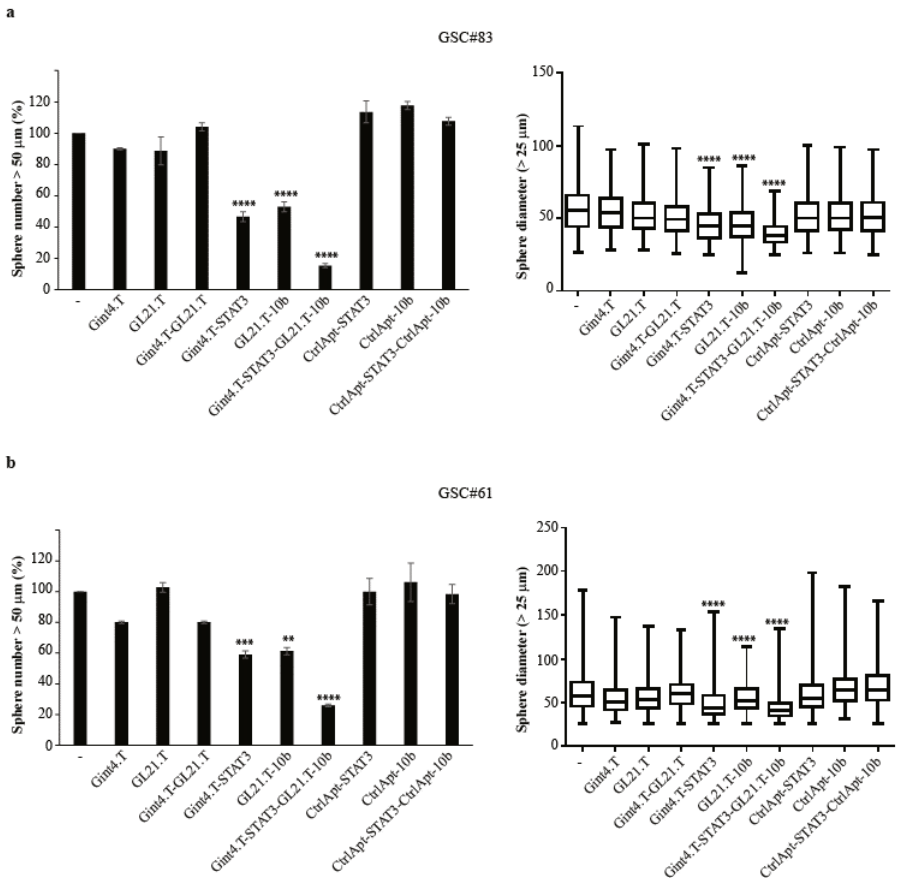
Figure 6. Gint4.T-STAT3 and GL21.T-10b combined effect on primary GSC tumour sphere formation. ( a , b ) Sphere formation of indicated primary GSC-derived tumour spheres (PDGFR β + ) left untreated ( − ) or treated with Gint4.T; Gint4.T-STAT3 or CtrlApt-STAT3; GL21.T-10b; or control aptamers—alone or in combination, as indicated. Left panels: Spheres with a diameter >50 μ m were counted and expressed as the percentage relative to the untreated samples ( − ), set to 100%. Vertical bars depict the mean ± SD ( n = 2). Right panels: Boxplot representation of the diameter measures (spheres with a diameter > 25 μ m). Statistics of the conjugate treatments versus the untreated samples were obtained using one-way ANOVA: **, p < 0.01; ***, p < 0.001; ****, p < 0.0001. 3. Discussion In the present study, we addressed the inhibition of GBM stem-like cells by an aptamer–siRNA molecule, combining the targeting of PDGFR β and STAT3 gene silencing. We used a previously described nuclease resistant conjugate (Gint4.T-STAT3) [25] containing an aptamer (Gint4.T) that binds and inhibits the receptor tyrosine kinase PDGFR β , [32], and a STAT3-specific siRNA. By using primary GSCs derived from patient with GBM tumours (WHO grade IV), we demonstrate the AsiC ability to alter self-renewal, viability, and migration. The high intra-tumour heterogeneity of GBM is a serious impediment to the effectiveness of conventional anticancer chemo and radiotherapies, which preferentially targets bulk tumour cells while sparing the more resistant cell populations, such as GSCs [2–6]. Therefore, development of therapeutic strategies aimed at targeting the resistant population has become an urgent need to enhance the responsiveness to treatments. The deregulated activity of STAT3 in cancer cells as well as in GSCs makes it a very promising therapeutic target for the development of an effective strategy for a complete tumour eradication.